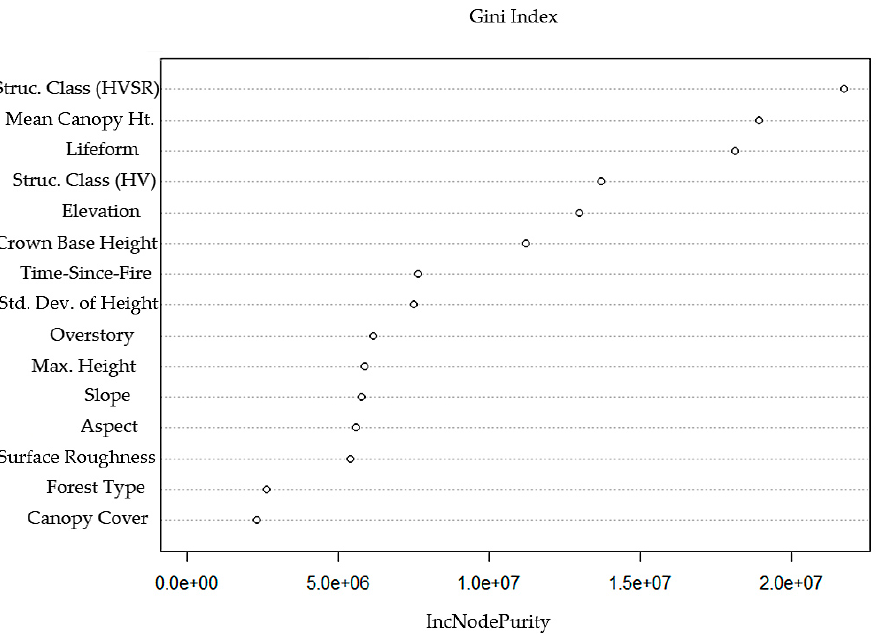
Figure 6. The “IncNodePurity” is used to evaluate to explanatory power of variables from the 20 m rasters based on the fire severity of a previous fire. The 3-digit structure class (HVSR; horizontal-vertical-surface roughness) and mean canopy height are influenced the most by previous fire severity. The structure class that includes only horizontal and vertical components (HV) had a weaker relationship with fire severity. Variables are ranked from most important at the top to least at the